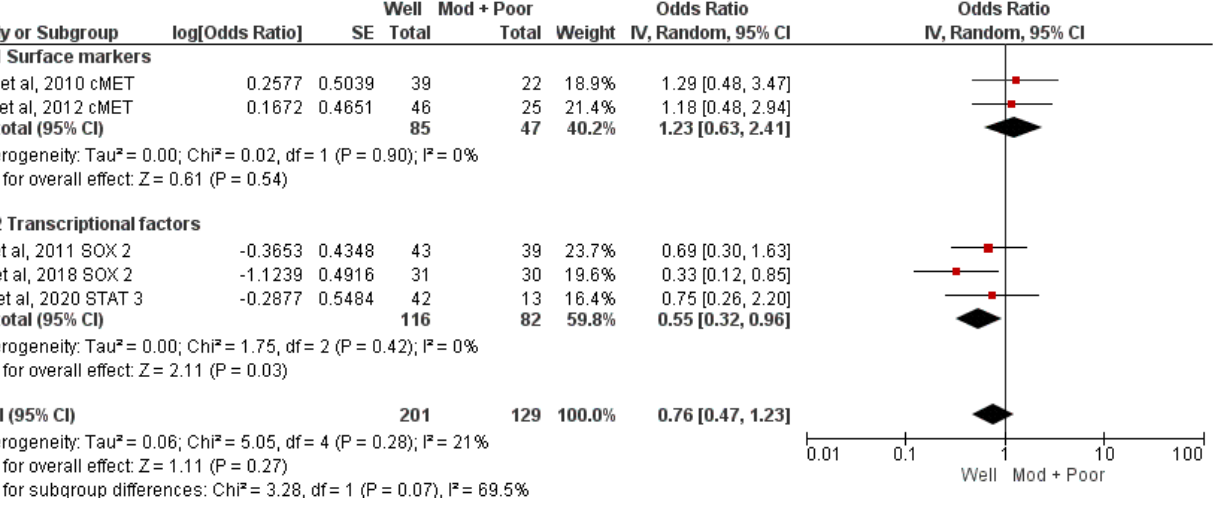
Figure 2. Meta−analysis of CSC markers and tumor stage [29–34].